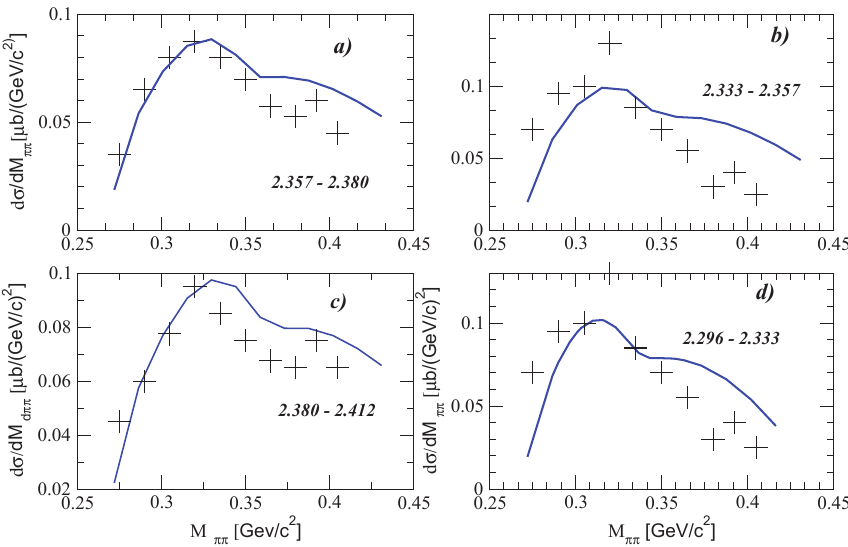
Figure 4. The distribution over the invariant mass of two final pions M ππ calculated according to the mechanism in Fig. 3 in di ff erent intervals of the d ππ invariant mass (shown in pictures) in comparison with the data [16] ( + ) and normalized to these